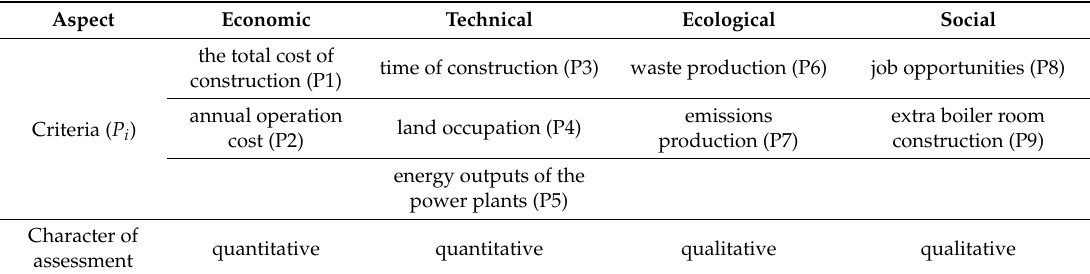
Table 2. Description of criteria.